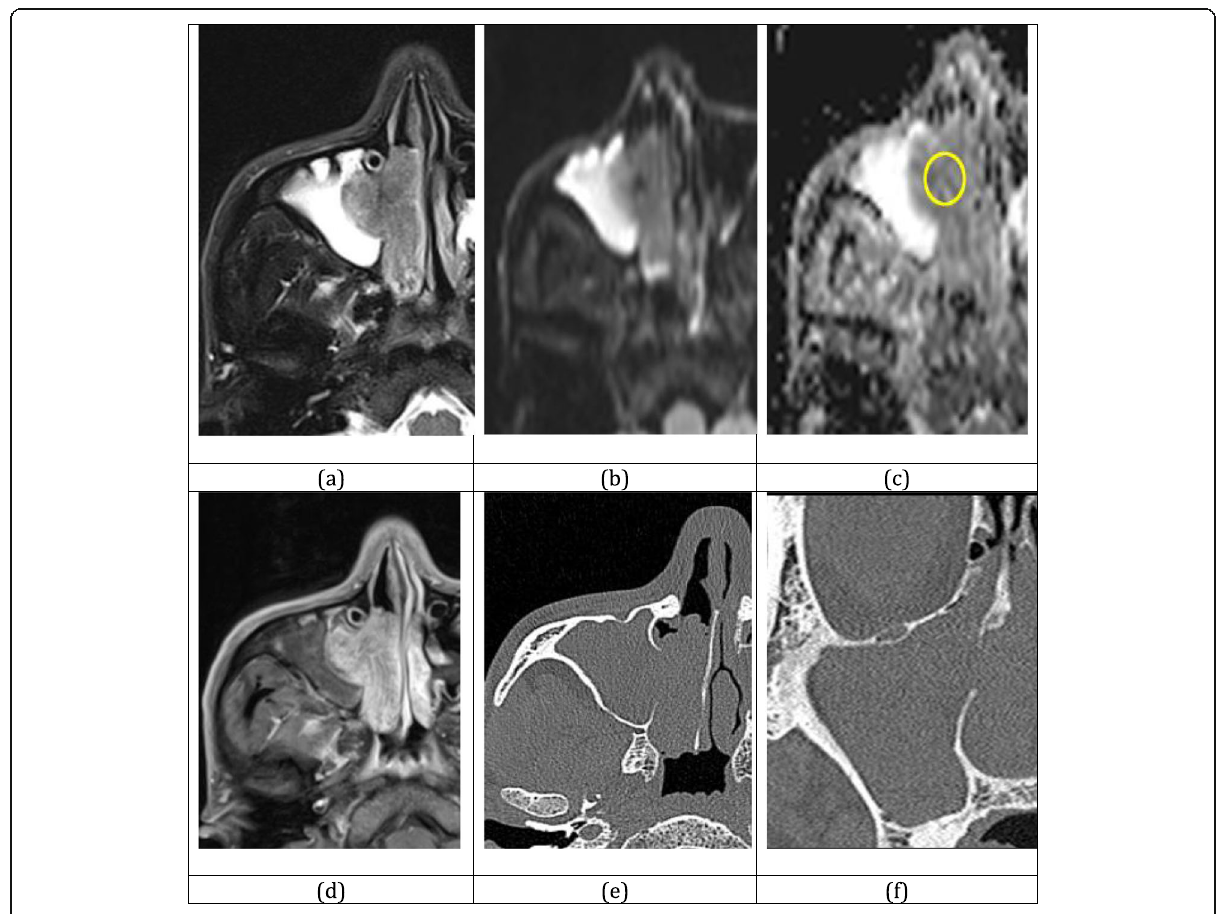
Fig. 4 A 52-year-old male presented with unilateral nasal obstruction and nasal inverted papilloma. Axial T2-weighted image reveals T2 linear divergent diffuse striations with T2 hypo-intensity with T2 ‘ black-out ’ ( b ) reflected by compact cellularity and low apparent diffusion co-efficient value measuring 1.1 × 10 -3 cm 2 /s as seen in apparent diffusion co-efficient map ( c ). Axial post-gadolinium-enhanced image ( d ) reveals the striations to be more conspicuous than in T2 image. Axial computed tomography ( e ) reveals rarefied and widened post-meatal accessory ostium and smooth remodeling of medial maxillary sinus wall. Coronal computed tomography image shows sino-maxillary opacification continuous through smoothly widened ostio-meatal unit with smooth sclerosis of the middle turbinate